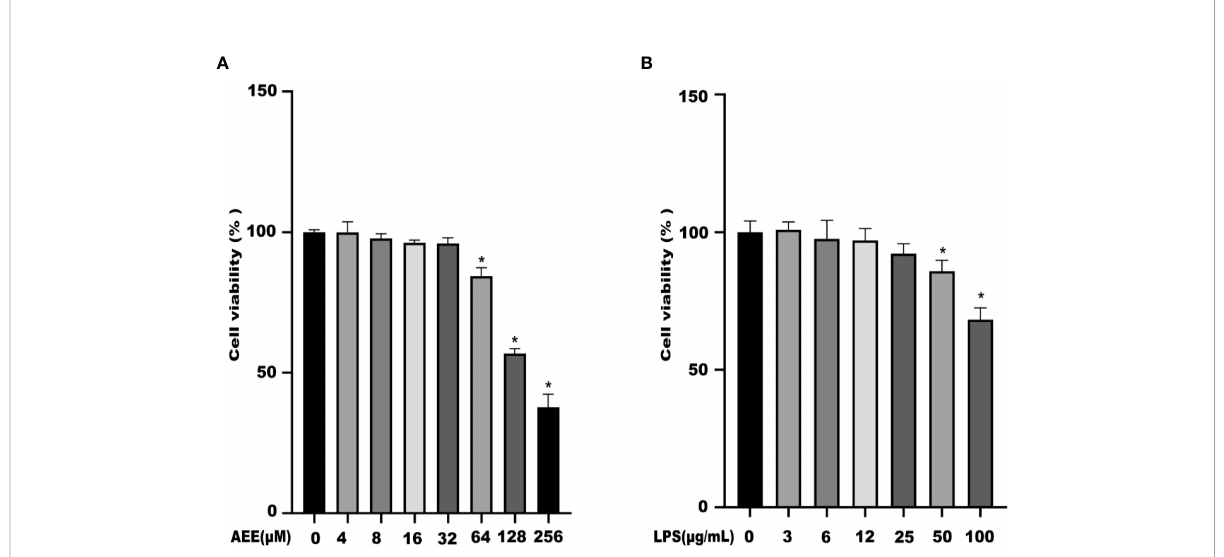
FIGURE 1 The effects of AEE and LPS with different concentrations on A549 cell viability, respectively. (A) AEE, (B) LPS. Values are presented as the means ± SD where applicable ( n = 6). * P < 0.05 compared to control